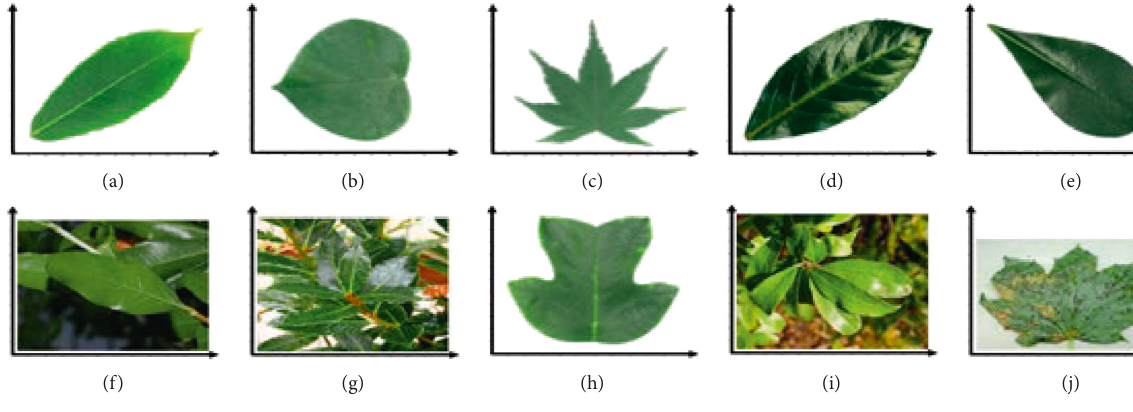
Figure 3: Sample of the leaf database.